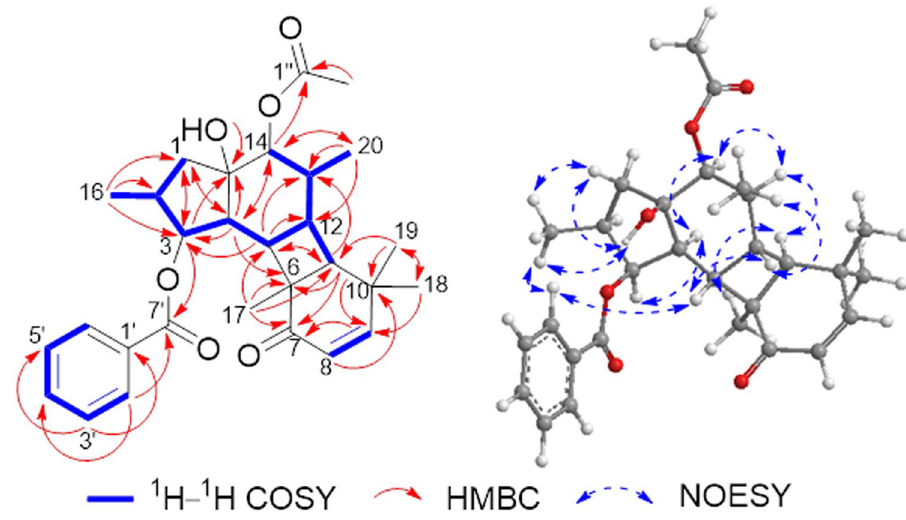
Figure 4. Key 1 H– 1 H COSY, HMBC and NOESY correlations for 2.